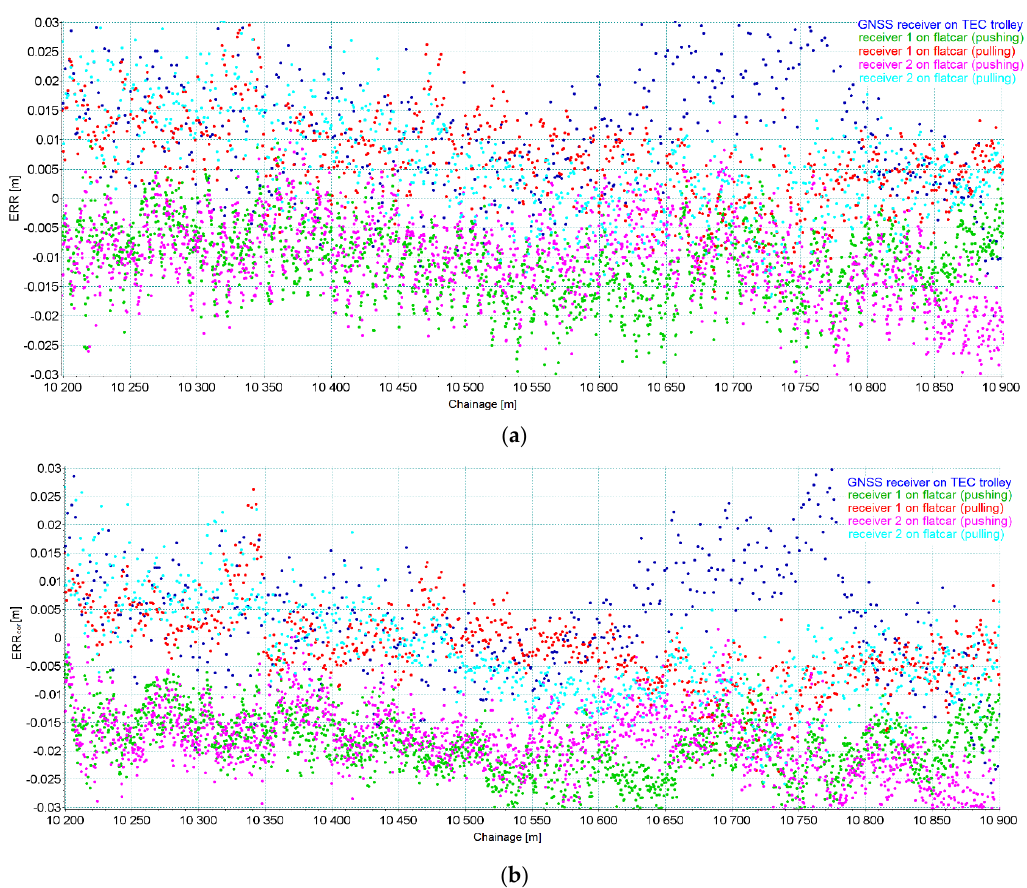
Figure 18. Signal of the 𝐸𝑅𝑅 value along the length of the entire circular curve with a radius of 𝑅 = 1000 m. ( a ) Signal before correction of the arc versines, ( b ) Signal after correction.